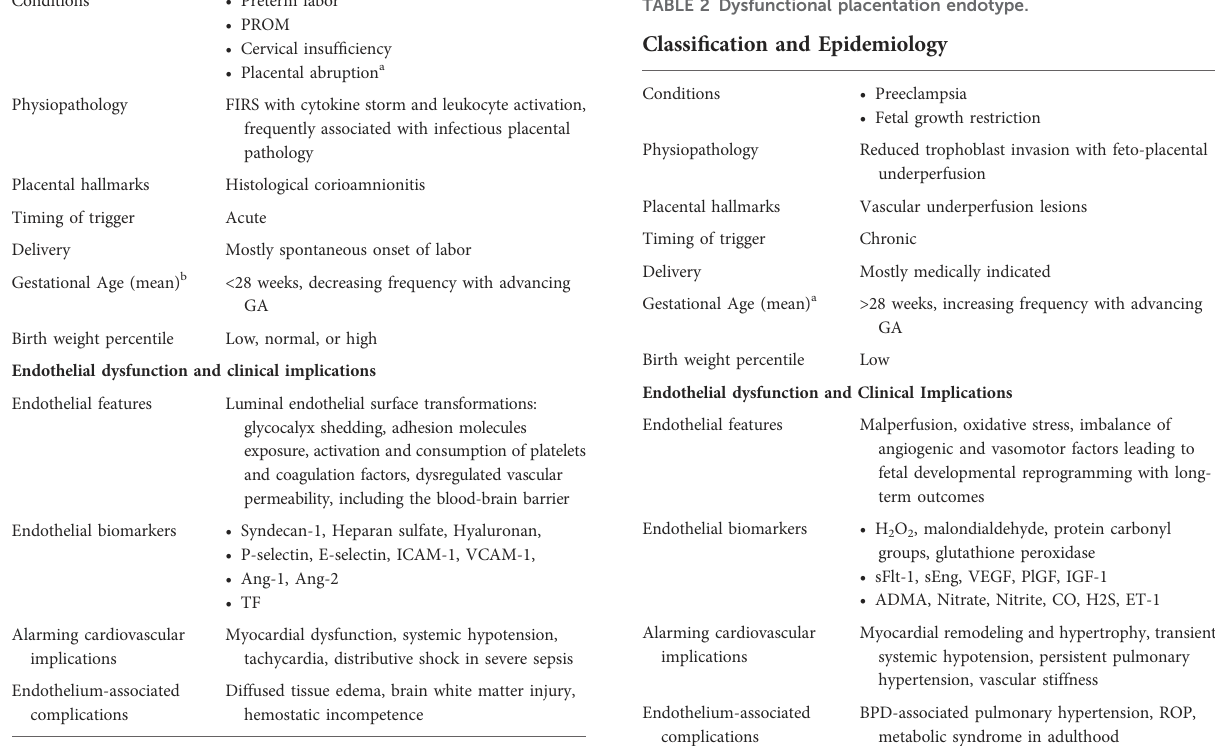
TABLE 2 Dysfunctional placentation